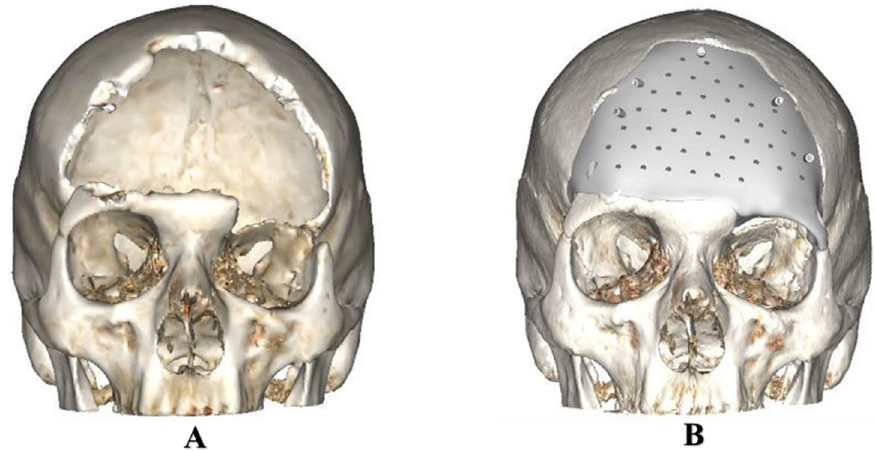
Figure 1. Illustration of a three-dimensional (3D) cranial defect reconstruction with a customized implant. ( A ) Cranial defect model. ( B ) Reconstruction with a customized or patient-speci fi c cranial implant model.